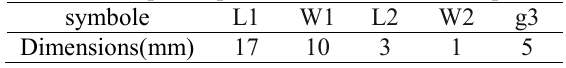
Figure 7: Simulated reflection coefficient for different W